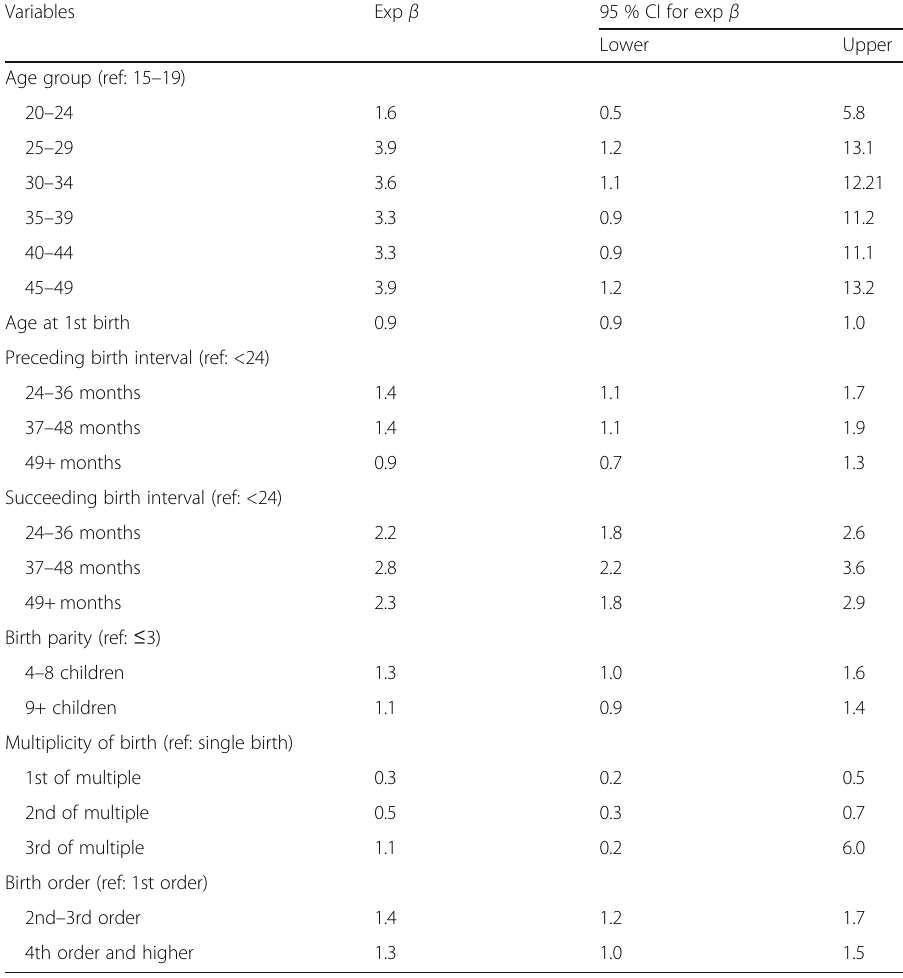
Table 2 Odds ratios of child mortality by maternal fertility behavior in Tanzania 2011 – 2015 Variables Exp β 95 % CI for exp β Lower